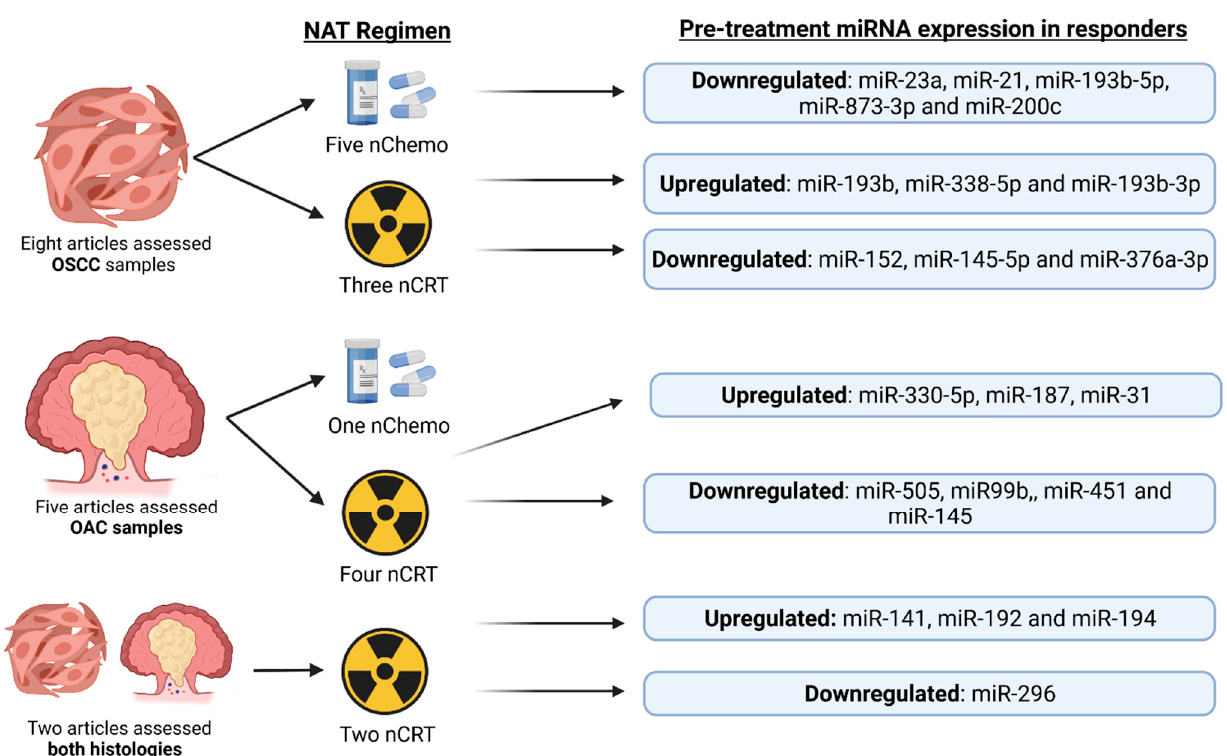
Figure 4. Overview of results produced by all 15 discussed articles. The NAT regimen utilised and how this relates to pre-treatment expression profiles in responders to nChemo or nCRT is shown. Abbreviations: OSCC; Oesophageal Squamous Cell Carcinoma, OAC; Oesophageal Adenocarcinoma, nChemo; Neopadjuvant chemotherapy, nCRT; Neoadjuvant Chemoradiotherapy. (Created with BioRender.com, accessed on 17 February 2022).